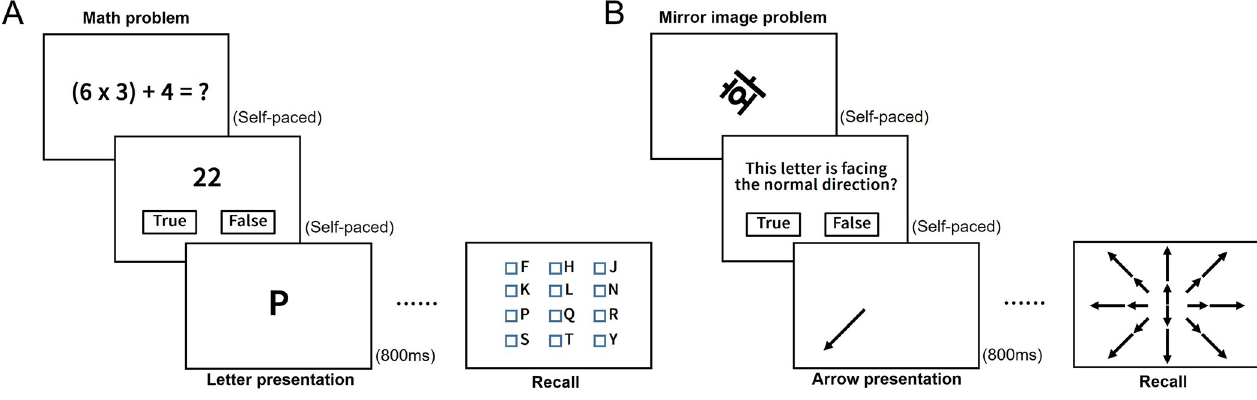
Fig 2. Task procedure for the (A) Operation and (B) Rotation Span tasks [44].